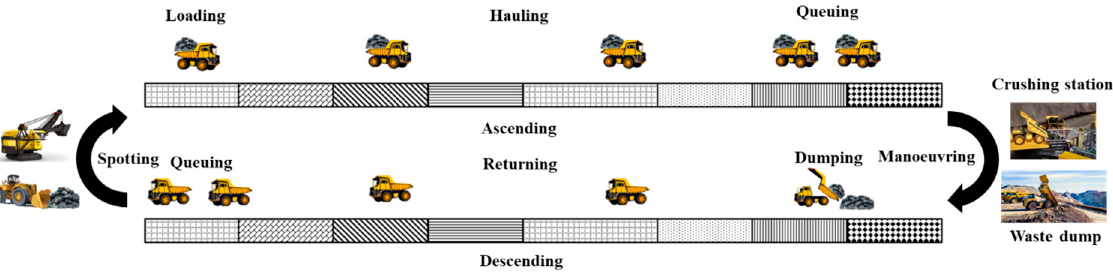
Figure 5. Conventional TS systems operating process.